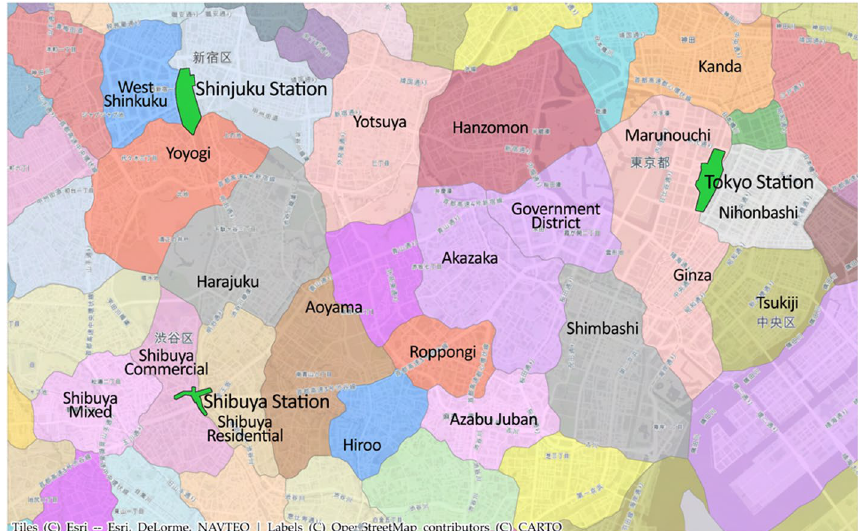
Fig. 10 Close-up map of the communities discovered using the greedy modularity using ω 1 edge weights based on all variables for 200 m